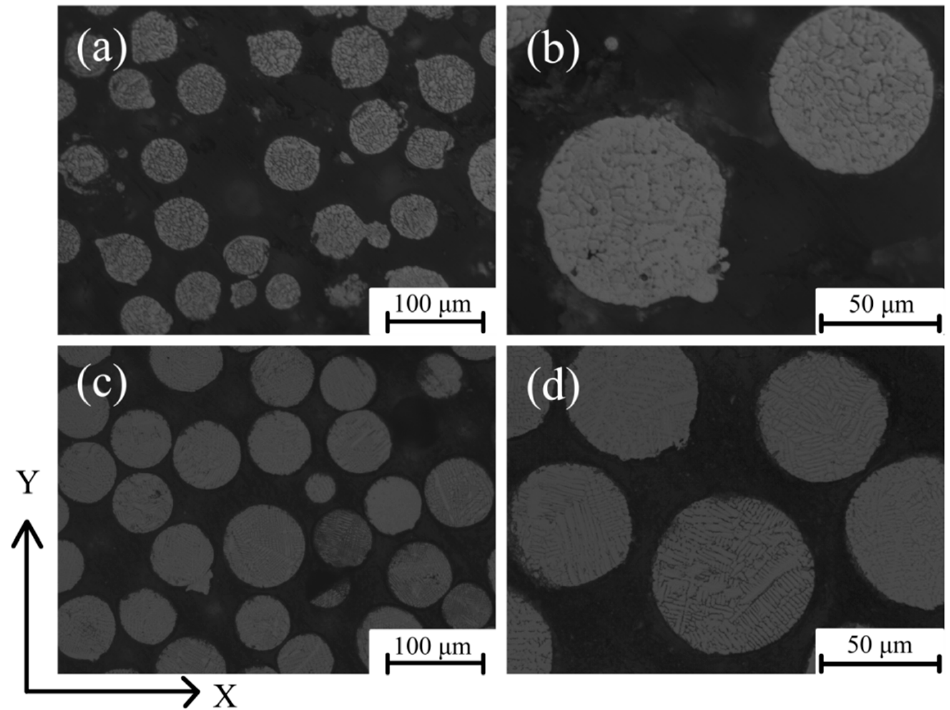
Figure 4. SEM micrographs of cross-section of the interior crystalline structure in the particles ( a , b ) GA; ( c , d ) PREP.